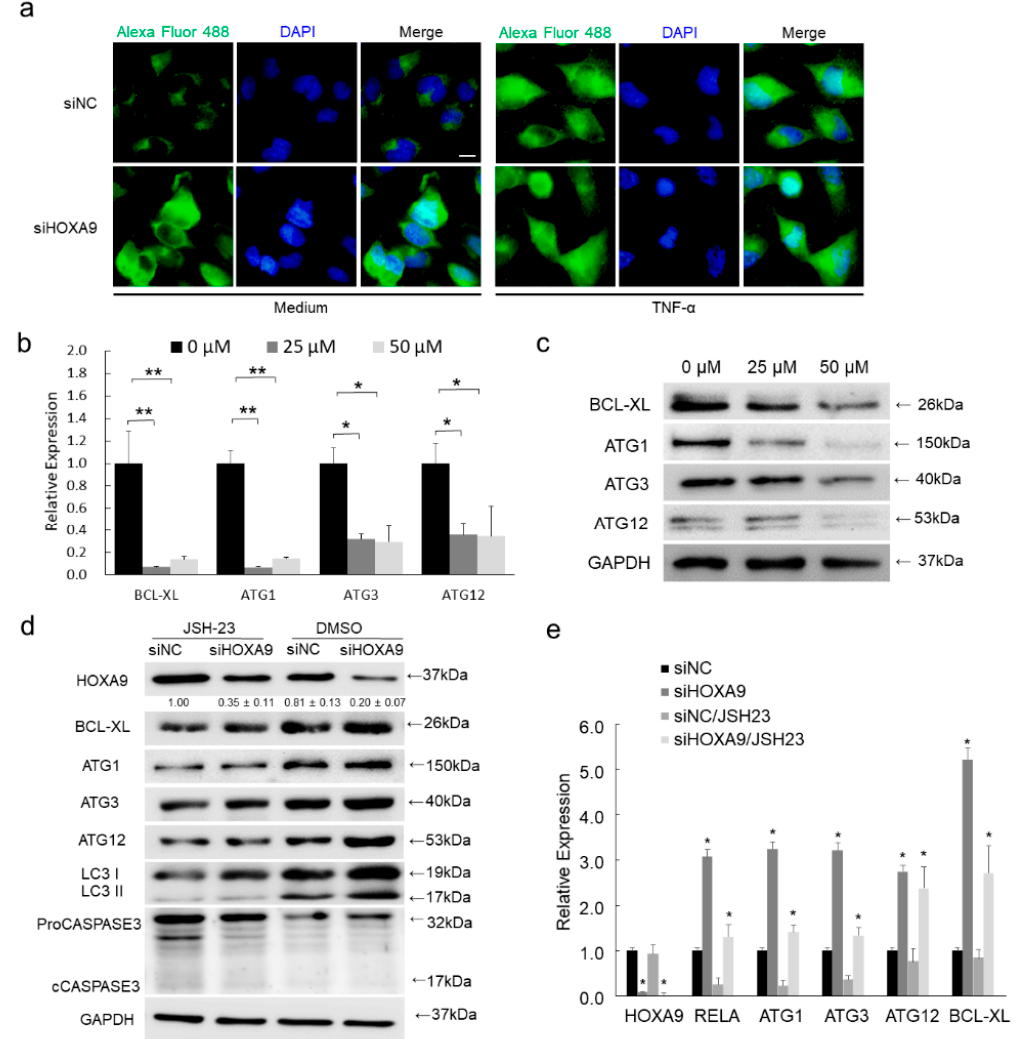
Figure 3. Loss of HOXA9 enhanced NF- κ B activity while inhibition of NF- κ B decreased the expression of BCL-XL, ULK1, ATG3, and ATG12. ( a ) Total RELA protein expression and RELA translocation to nucleus was detected by IF staining. ( b , c ) The expression levels of BCL-XL, ULK1, ATG3, and ATG12 in both mRNA and protein levels were detected after the treatment with NF- κ B inhibitor JSH-23 using 25 or 50 μ M. ( d , e ) JSH-23 treatment was performed after HOXA9 knockdown to verify the effects of RELA in regulating the mRNA and protein expression levels of BCL-XL, ULK1, ATG3, and ATG12. The bands of HOXA9 were densimetrically quantified ( n = 3). * p < 0.05, ** p < 0.01, *** p < 0.001.